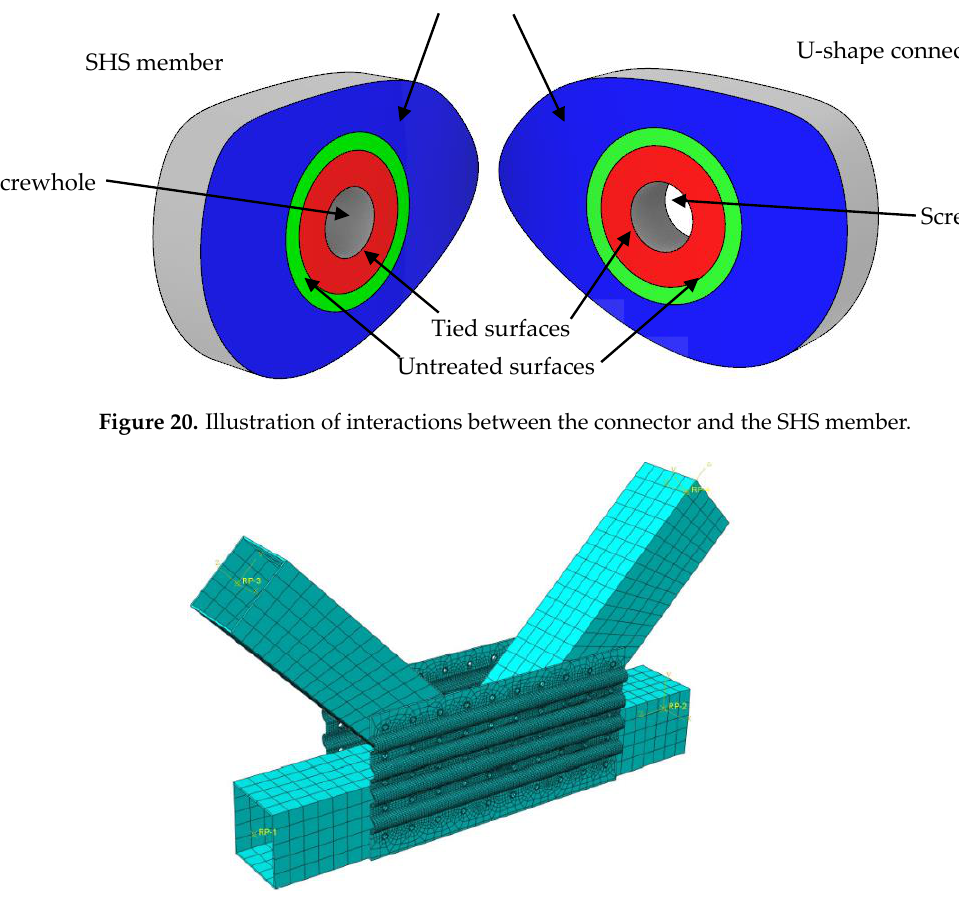
Figure 21. Mesh model of typical K-joint specimens using the UTW connector.